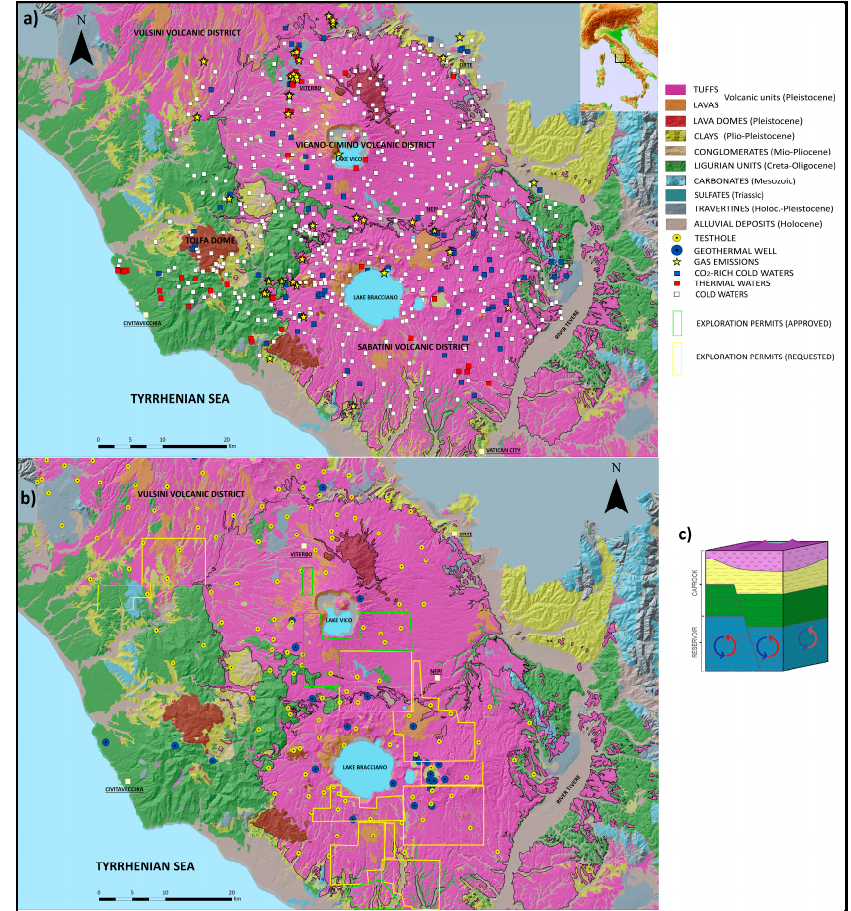
Figure 1. ( a ) Geological sketch map of the Vicano–Cimino Volcanic District (VCVD) and Sabatini Volcanic District (SVD) showing the location of the fluid sampling sites; ( b ) location of test-holes, geothermal wells, and exploration permits (from [12,35]); ( c ) simplified geological model for the VCVD and SVD geothermal systems (from